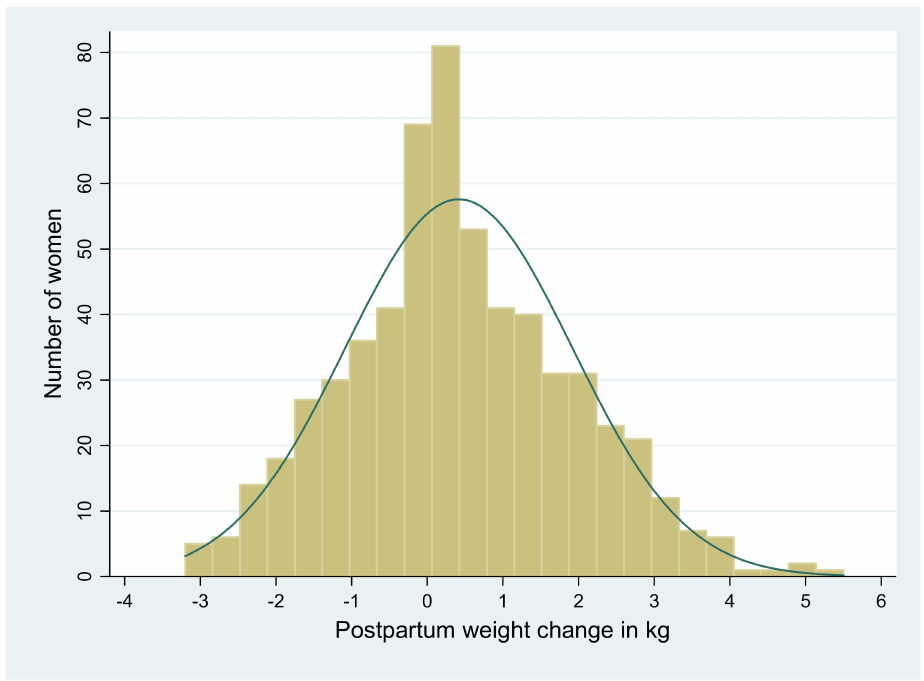
Figure 1. Distribution of postpartum weight change in kg among 585 women from the Tigray region, northern Ethiopia, 2018.